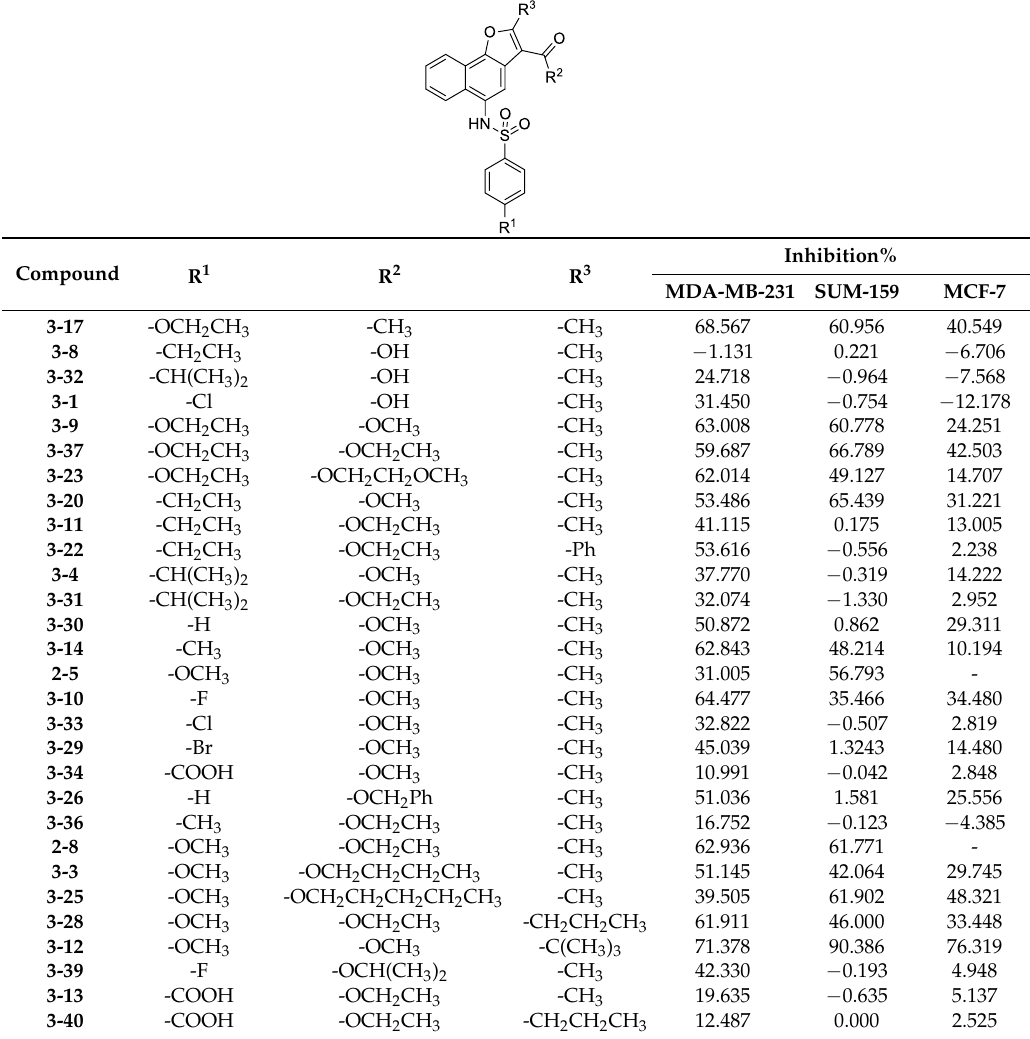
Table 3. Inhibition rates of analogs of 2-5 and 2-8 identified by 2D similarity search (Part 1).